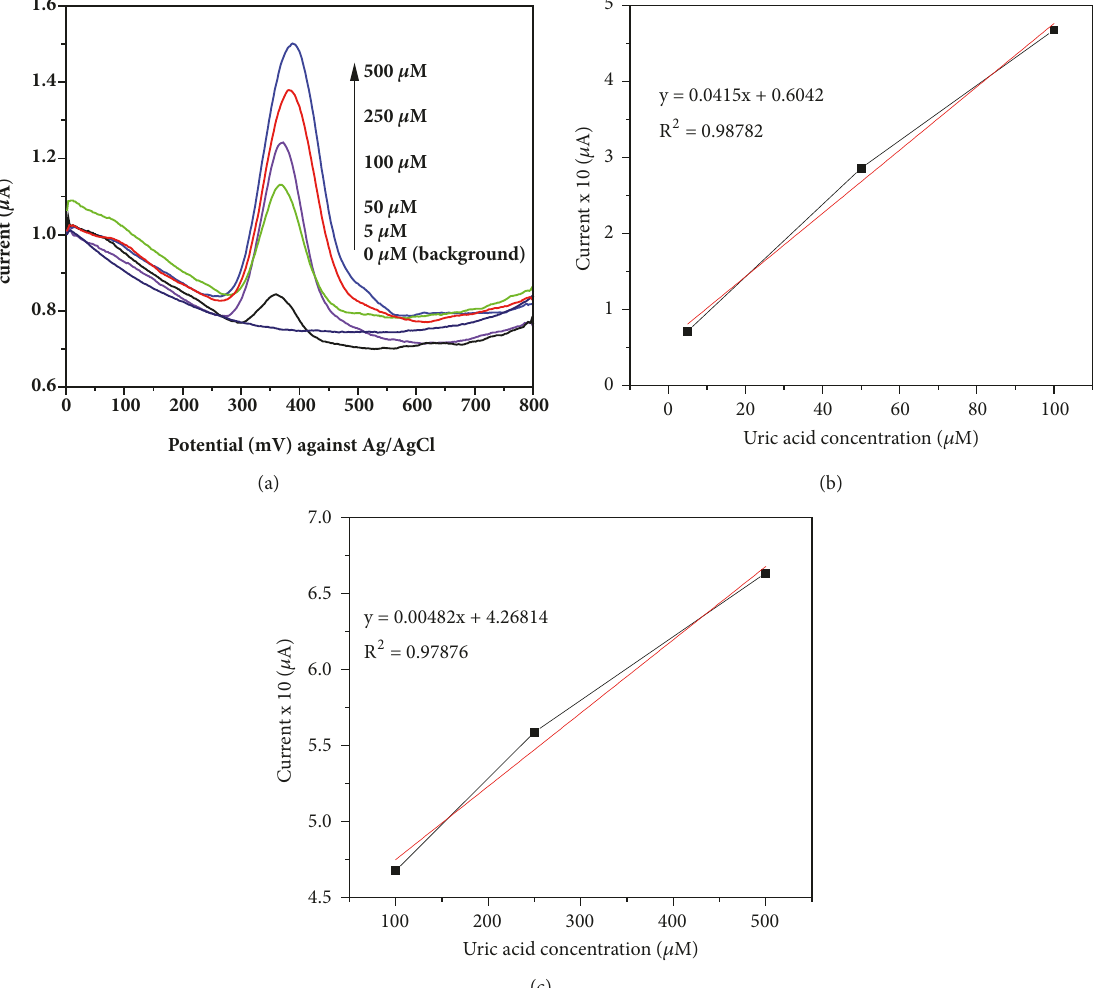
Figure 4: (a) Differential pulse voltammetry (a) of different concentrations of uric acid (0 𝜇 M, 5 𝜇 M, 50 𝜇 M, 100 𝜇 M, and 500 𝜇 M) in 0.1 M PBS (pH 7) at scan rate of 10 mV/s, pulse amplitude of 240 mV, and pulse period of 100 ms, and plot of peak current versus the linear dynamic range concentration of UA (1-100 𝜇 M (b) and 100-500 𝜇 M (c)).